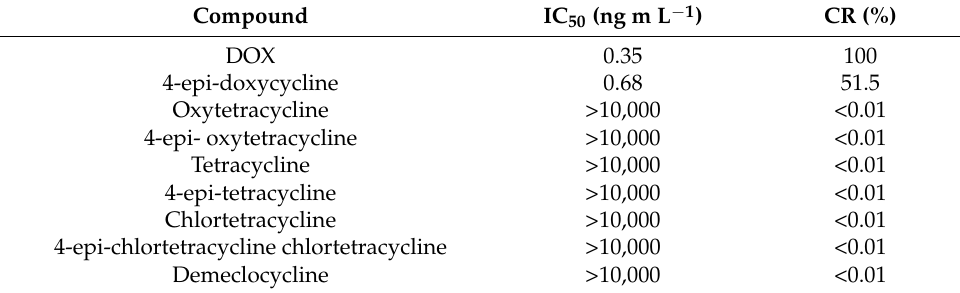
Figure 3. ( a ) Standard curves of our developed QD-cFIA with increasing DOX concentrations, from top to bottom: 0.003, 0.01, 0.03, 0.1, 0.3, 1, 3, 10, 30, and 100 ng mL − 1 , respectively. ( b ) Good linearity of the calibration curves was achieved for DOX in the range of 0.1–3 ng mL − 1 . Error bars represented the standard deviation. Table 2. Cross-reactivity of analogues related to DOX by QD-cFIA.